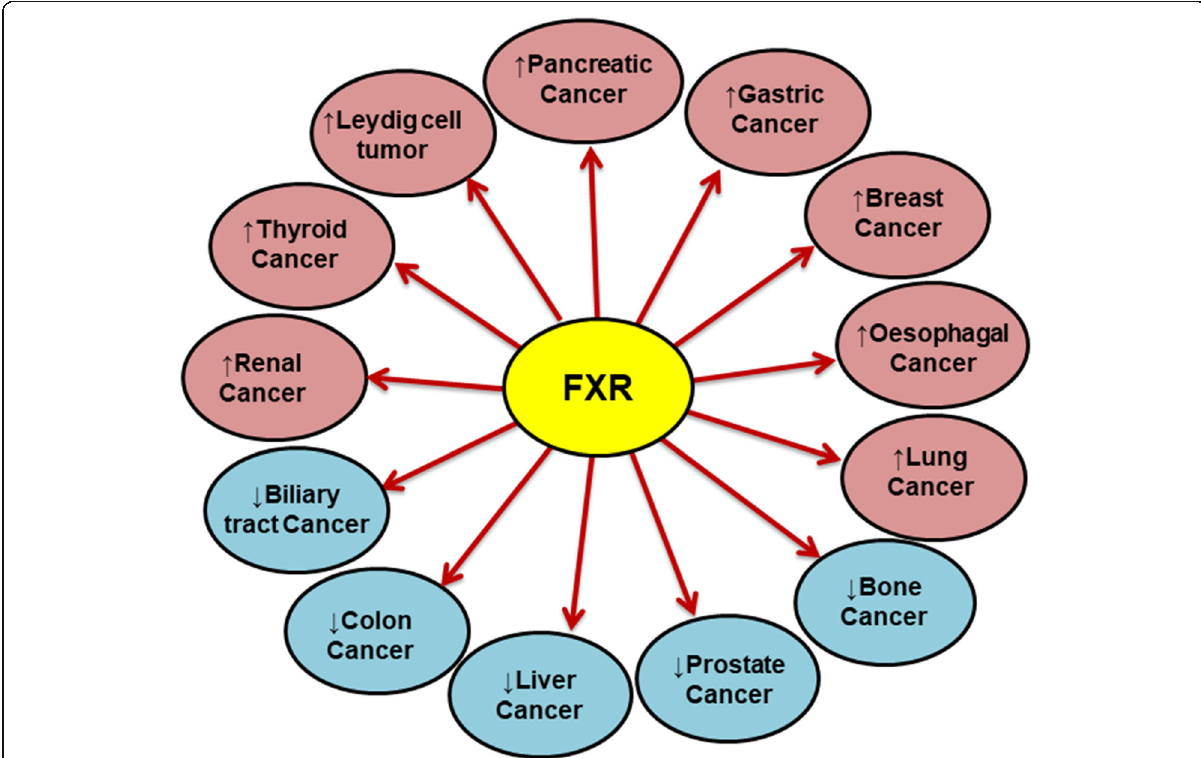
Fig. 2 Expression of FXR in various cancers. The arrow in the circle represents the expression of FXR in the respective cancers. “ ↑ ” represents overexpression of FXR and “ ↓ ” represents the low expression of